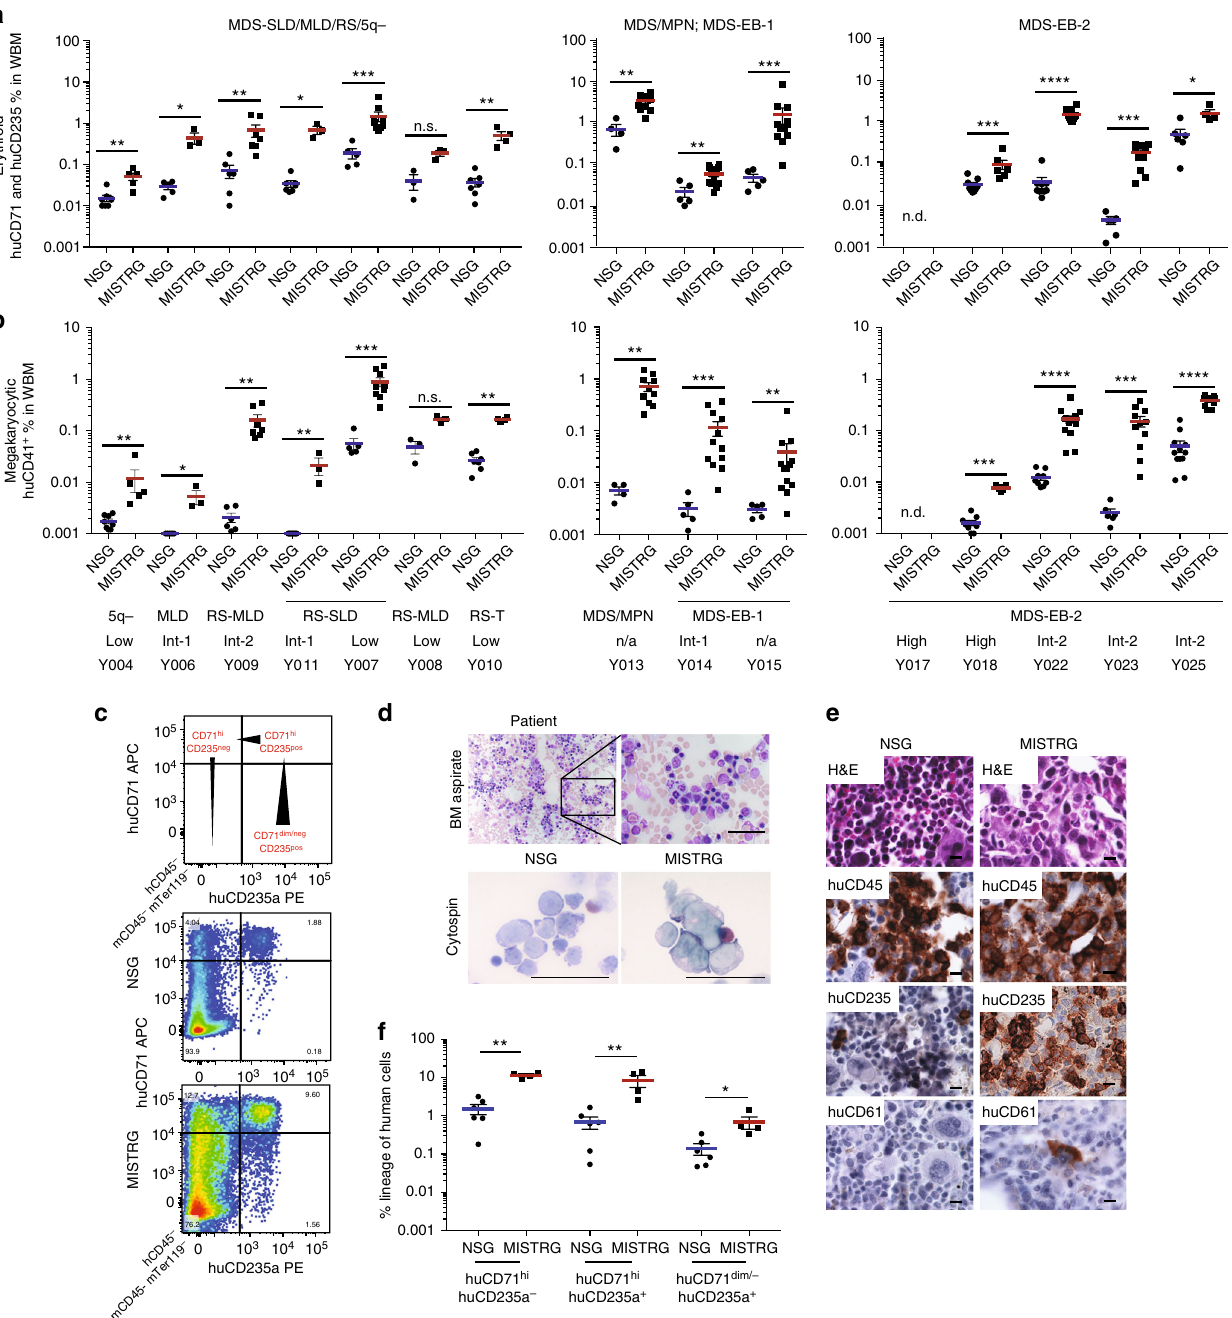
Fig. 3 Erythroid and megakaryocytic lineage representation in myelodysplastic syndrome (MDS) MISTRG xenografts. a Analysis of human erythroid lineage output in NSG versus MISTRG mice engrafted with lower- and higher-risk MDS (as in Fig. 2) via determination of CD71 + / − huCD235 − / + expression in hu/muCD45 − muTer119 − bone marrow (BM). b Analysis of human megakaryocytic lineage output (MK and platelets) in NSG versus MISTRG mice (engrafted as in Fig. 2) via determination of huCD41 + in hu/muCD45 − BM. c NSG and MISTRG xenografted with MDS-EB-2 (Y025) BM with inverted myeloid/erythroid ratio. d Patient BM aspirate (top) and sorted human erythroblasts from engrafted NSG and MISTRG BM (bottom) (for overall engraftment see Fig. 2c, Y025). e Representative BM histology from representative NSG and MISTRG recipients engrafted >1% stained with hematoxylin and eosin (H&E), huCD45, huCD235, and huCD61. f Representative fl uorescence-activated cell sorting (FACS) plots of erythroid lineage differentiation based on huCD71 and huCD235 expression in huCD45 − muCD45 − mTer119 − cells (huCD71 hi huCD235a − (pro-erythroblasts (EB)), huCD71 hi huCD235a + (basophilic EB/normoblasts), huCD71 − huCD235a + (reticulocytes, RBC)) MDS diagnosis sample (MDS-EB-1, Fig. 4e). This IDH1 mutation in the MDS diagnosis sample at a VAF of ~1% (Fig. 4e, middle was not reported in the patient at the time of MDS diagnosis, but panel, Supplementary Tables 1 and 2). Interestingly, in the sAML present at the time of disease progression to sAML (sAML, VAF engrafted MISTRG mice, a new NRAS G12S mutation de fi ned the 24%, Fig. 4e). Re-sequencing detected the IDH1 R132C mutation dominant clone, again detectable in the patient ’ s sAML at a VAF NATURE COMMUNICATIONS| (2019) 10:366